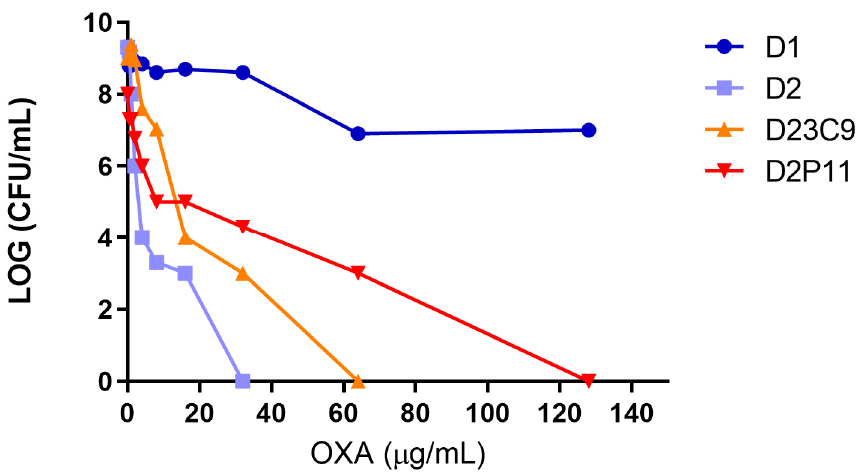
MIC: Minimal inhibitory concentration, VAN: vancomycin, OXA: oxacillin, RIF: rifampin, DAP: daptomycin, PAP-AUC: Population analysis profile and area under the curve.